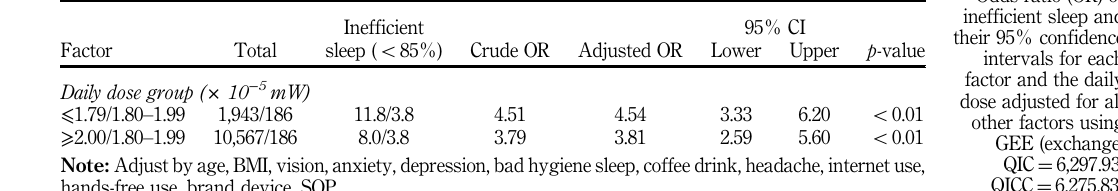
Table IV. Odds ratio (OR) of inefficient sleep and their 95%